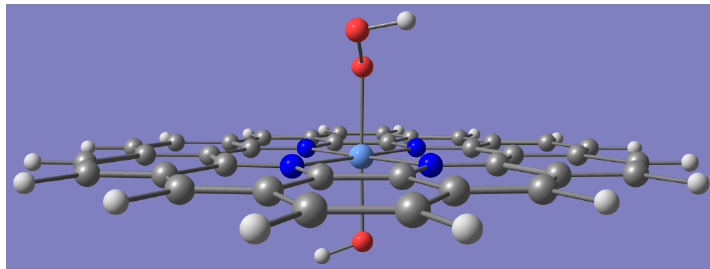
Figure 3. The structure of Cr(OH)N 4 + OOH (ads) .